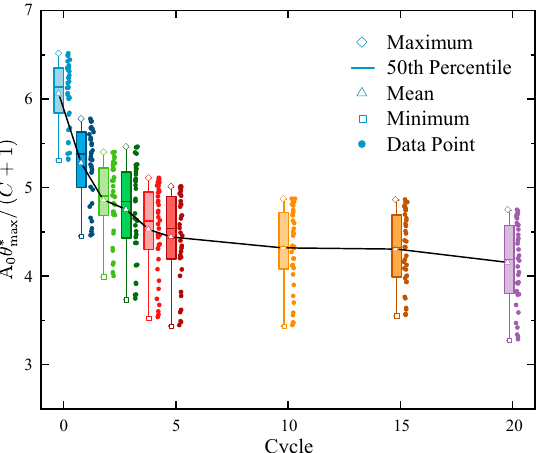
Figure 12. Box-and-whisker plot of the statistical roughness parameter for cyclic sheared joints under 2.5 MPa.